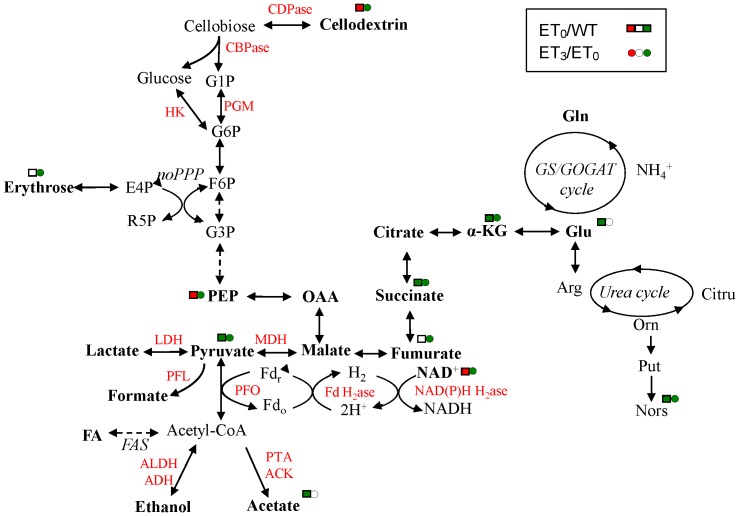
Metabolic pathway representation of intramolecular metabolite change.Significantly changed intramolecular polar metabolites in C. thermocellum wild-type strain (WT) and ethanol-tolerant strain without additional ethanol (ET0) and with 3% ethanol (ET3) were mapped on the existing metabolic pathways. The red and green symbols indicate significantly increased and decreased metabolites, respectively. Metabolites: G1P, glucose 1-phosphate; G6P, glucose 6-phosphate; F6P, fructose 6-phosphate; G3P, glyceraldehyde 3-phosphate; E4P, erythrose 4-phosphate; R5P, ribose 5-phosphate; PEP, phosphoenolpyruvate; OAA, oxaloacetic acid; α-KG, α-ketoglutaric acid; Glu, glutamic acid; Gln, glutamine; Arg, arginine; Citru, citrulline; Orn, ornithine; Put, putrescine; Nors, norspermidine; FA, fatty acid. Enzymes: ACK, acetate kinase; ALDH/ADH, acetaldehyde dehydrogenase/alcohol dehydrogenase; CDPase, cellodextrin phosphorylase; CBPase, cellobiose phosphorylase; HK, hexokinase; PGM, phosphoglucomutase; LDH, lactate dehydrogenase; MDH, malate dehydrogenase; PTA, phosphotransacetylase; PFL, pyruvate:formate lyase; PFO, pyruvate:ferredoxin oxidoreductase; Fd H2ase, ferredoxin hydrogenase; NAD(P)H H2ase, NAD(P)H hydrogenase.